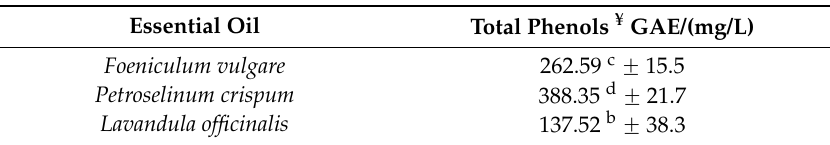
Table 2. Total phenolic content (mg of Gallic Acid Equivalents/L) in organic fennel, parsley, and lavender essential oils from